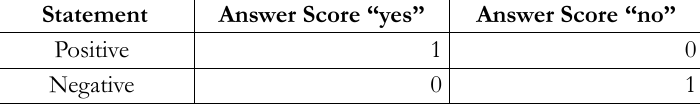
Table 1. Student questionnaire